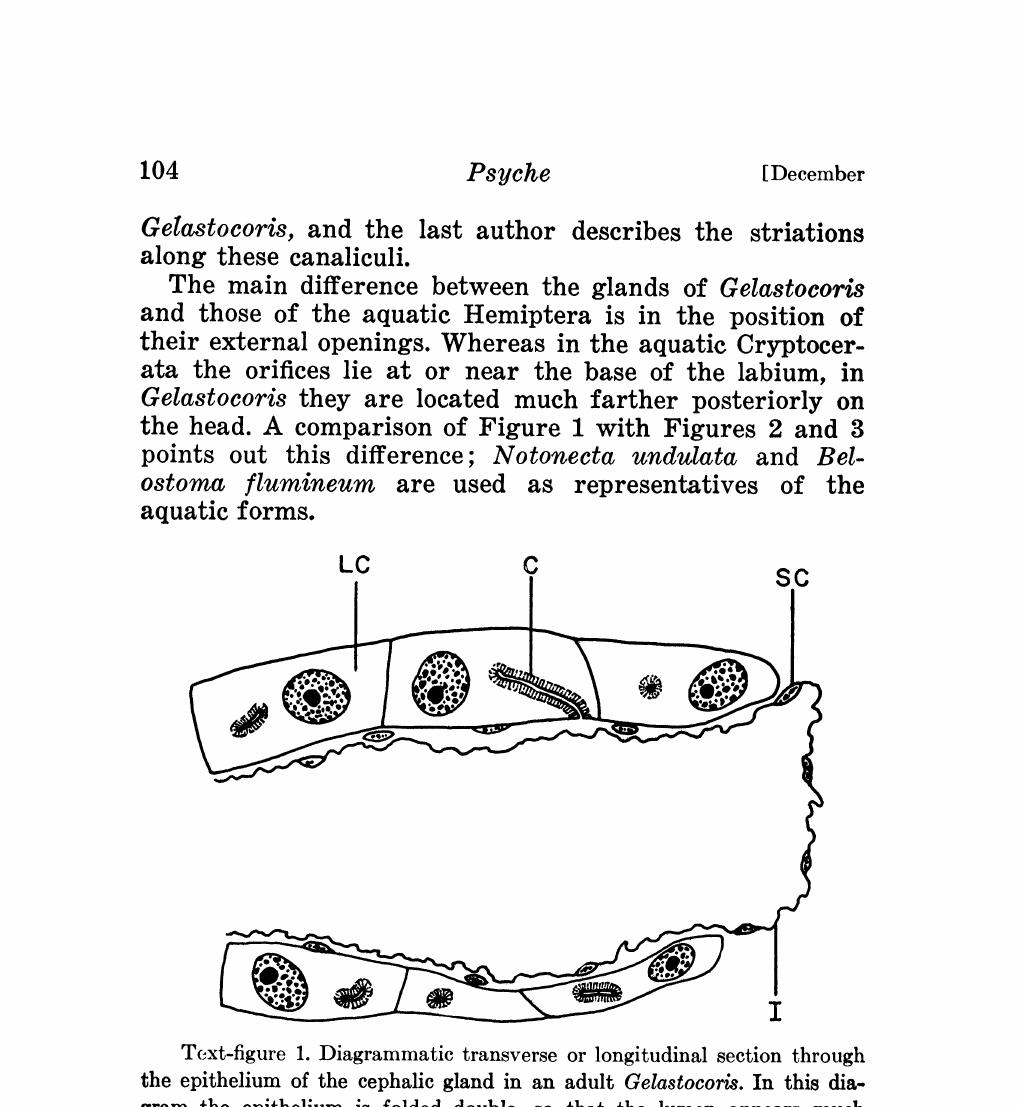
Text-figure 1. Diagrammatic transverse or longitudinal section through the epithelium of the cephalic gland in an adult Gelastocoris. In this dia- gram the epithelium is folded double, so that the lumen appears much narrower than it actually is. The canaliculus of the upper middle large cell i shown opening onto the lumen of the gland; the other canaliculi are diagrammed in transverse or oblique section. 700 X. Abbreviations used in figure" C large cell; SC- small